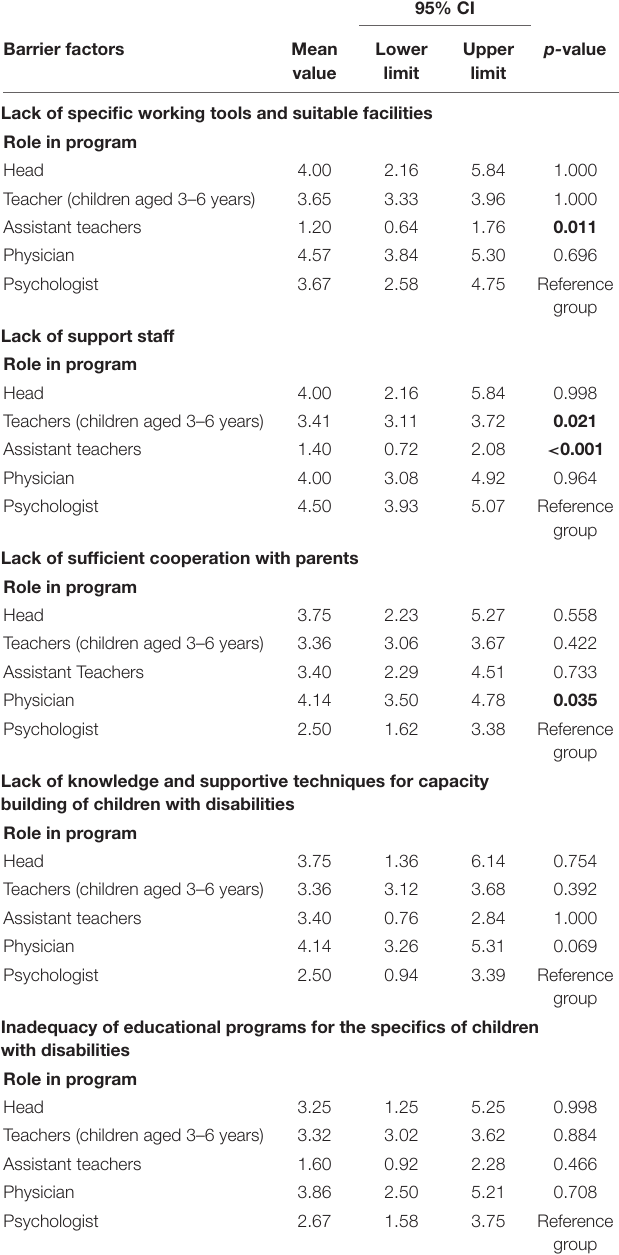
TABLE 5 | The associations (Tamhane’s T2 test) between barrier factors and the role that participants play at the institution; mean values from the general linear model (responses from a total of 107 child education